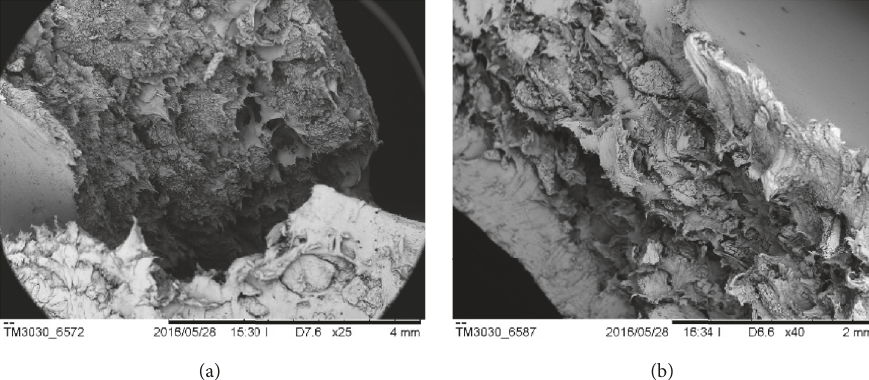
Figure 11: SEM pictograph of fracture surface of impact test: (a) composite type B3 and (b) composite type D3.